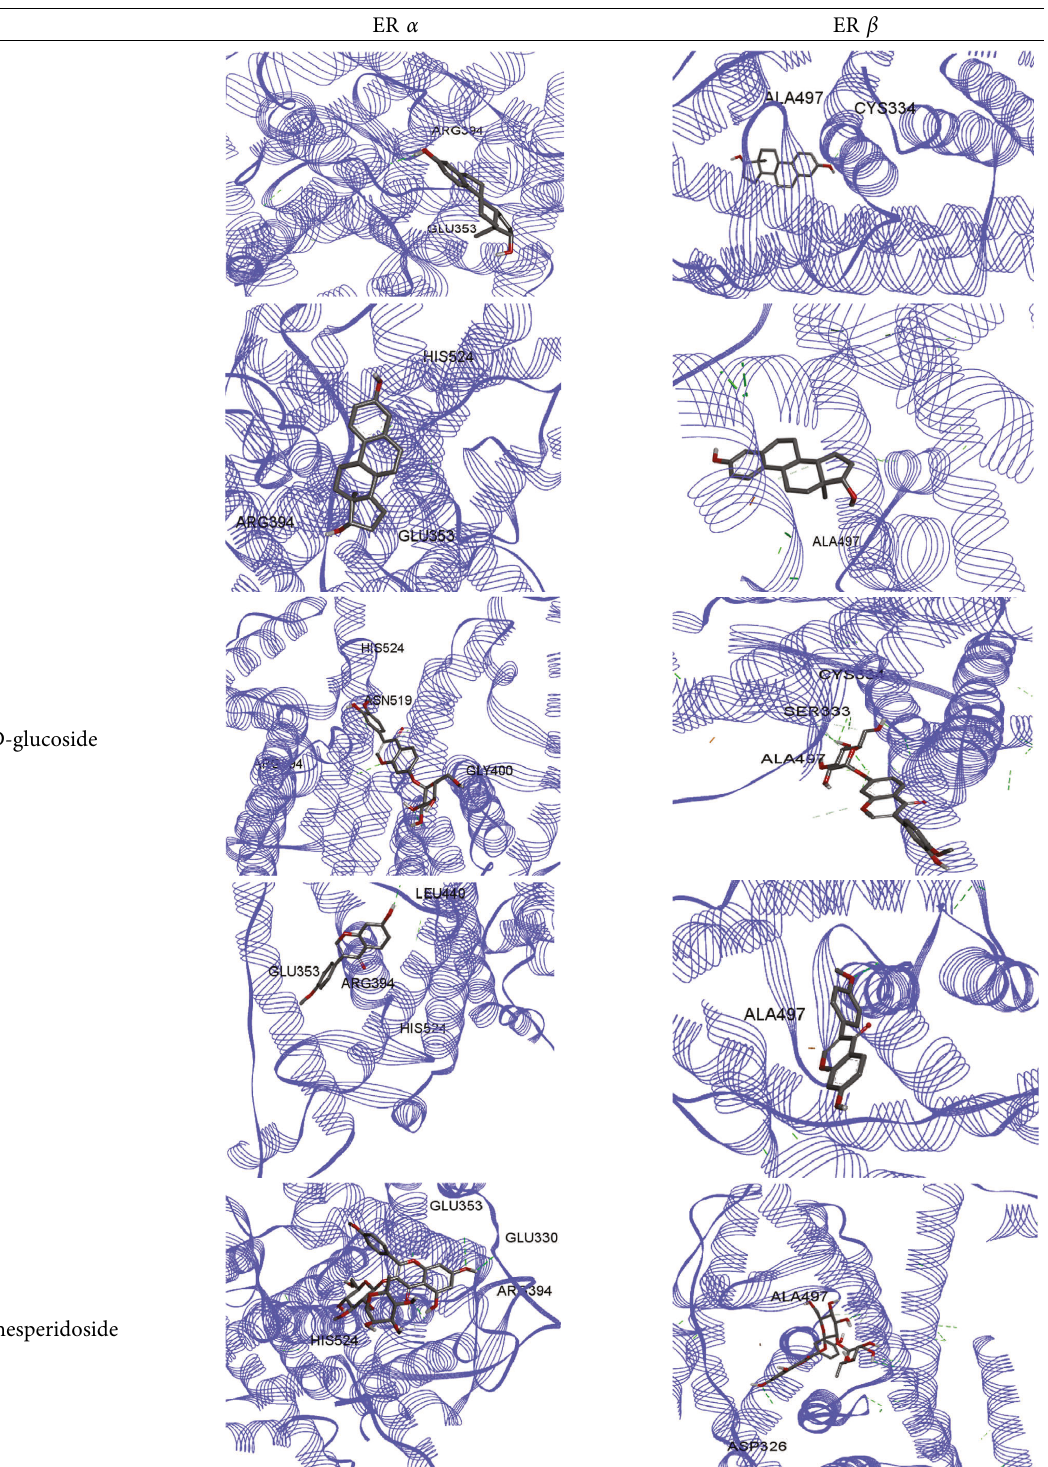
Table 3: Interaction between amino acids in the binding site of ERs α and β , and standard agonist (estradiol), standard antagonist (finasteride), and components (calycosin-7-O-beta-D-glucoside, formononetin, kaempferol-3-O-neohesperidoside, and kaempferol-3-O- sophoroside) identified by